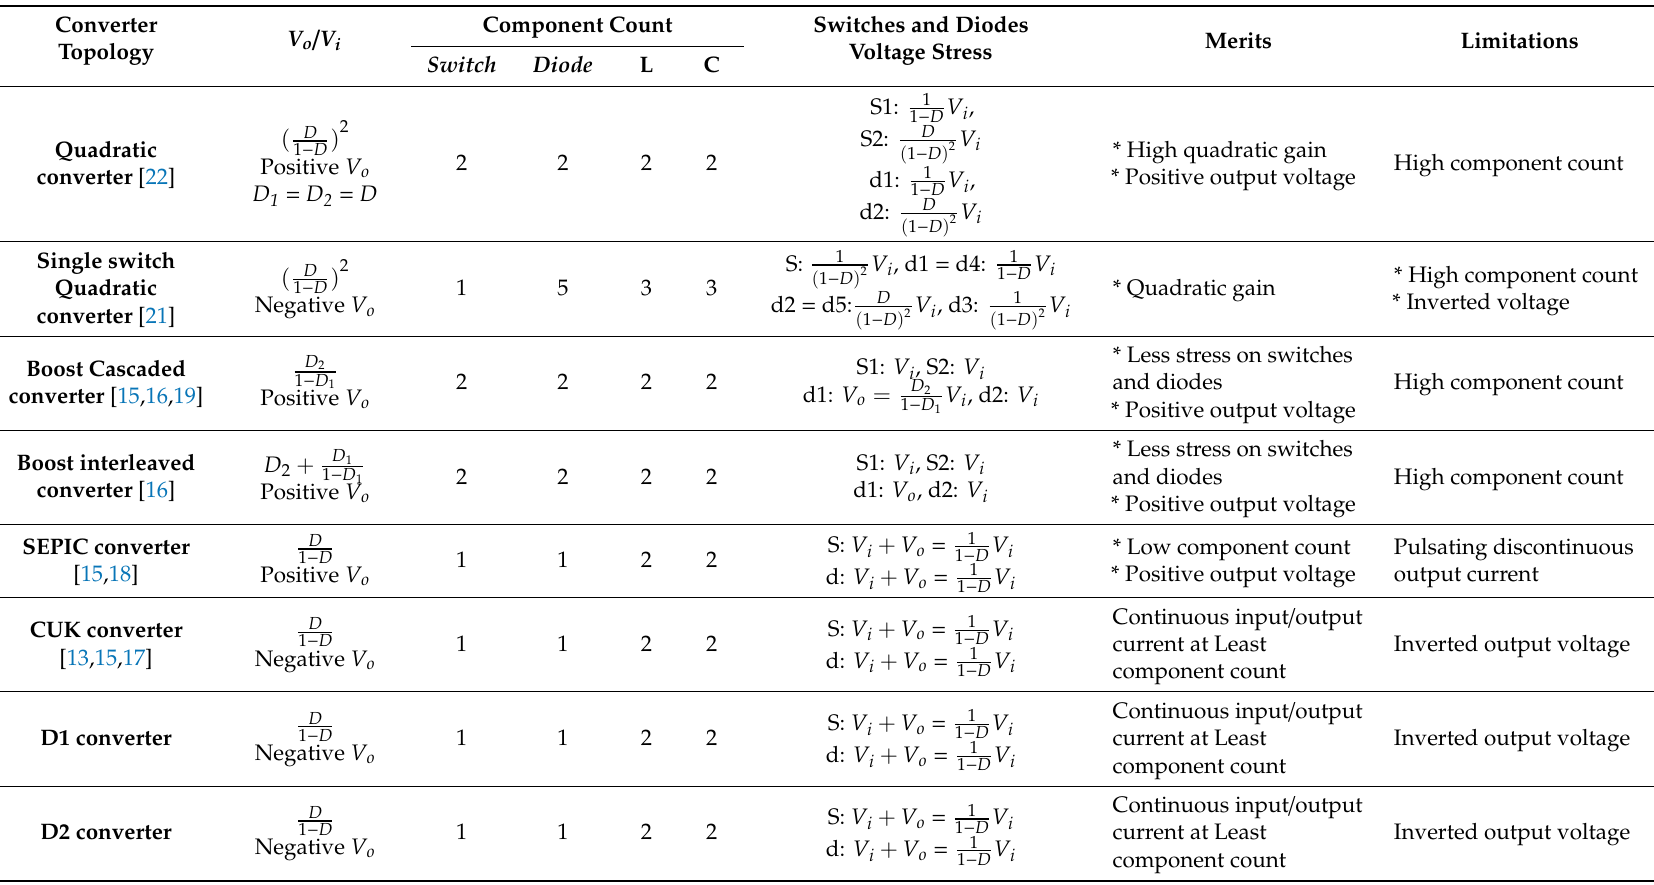
Table 1. Comparison between most recent continuous-input-current buck-boost direct current (DC) / DC